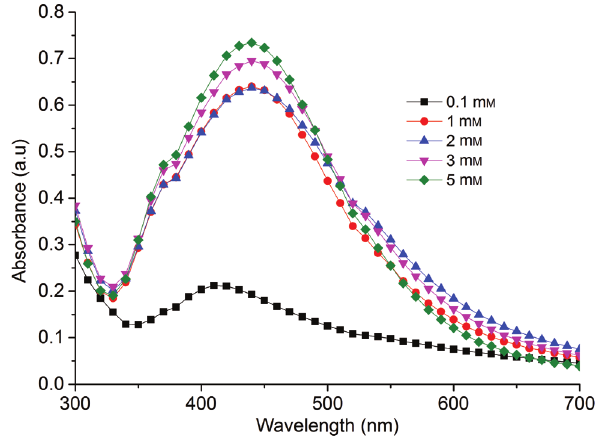
Figure 3: Effect of silver ion concentration on AgNPs synthesis.